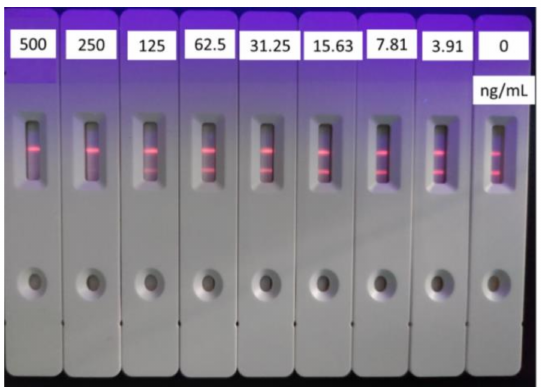
Figure 6. Standard curve for tylosin with coating antigen of 0.25 mg/mL ( n = 3). (The concentration of second antibody is 0.093